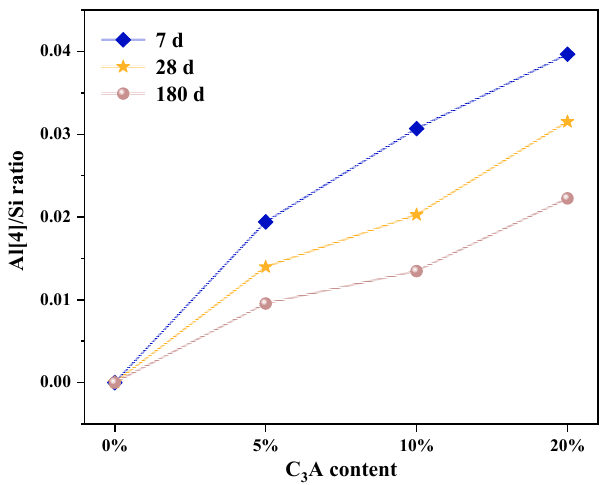
Figure 5. Al(4)/Si variation of C-S-H gel in C 3 S-C 3 A paste under sulfate attack.